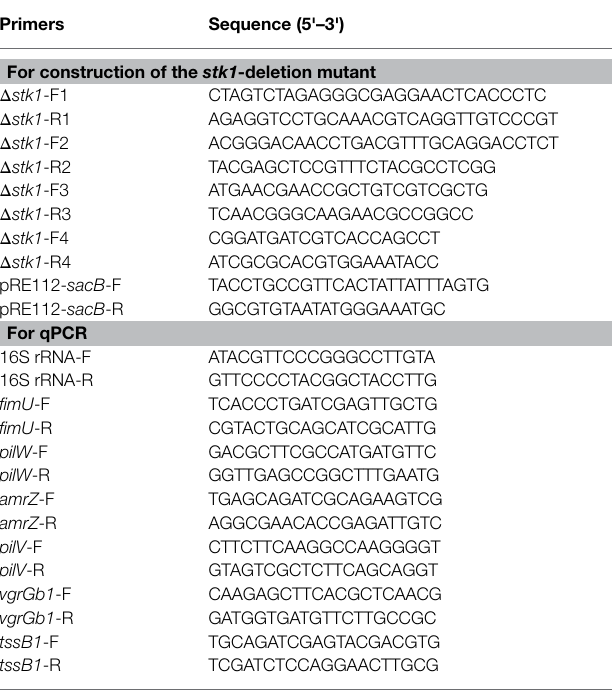
TABLE 1 | Oligonucleotide primers used for construction of the stk1 -deletion mutant and qPCR.